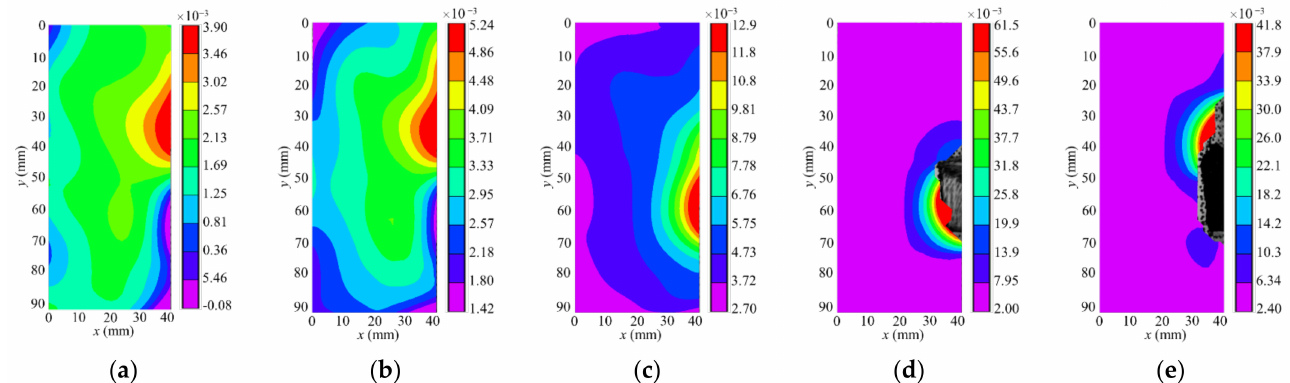
Figure 7. Principal strain fields at different stress stages corresponding to key points ( a – e ) in Figure 6 (Note compressive strain is taken as negative and tensile strain is taken as positive).